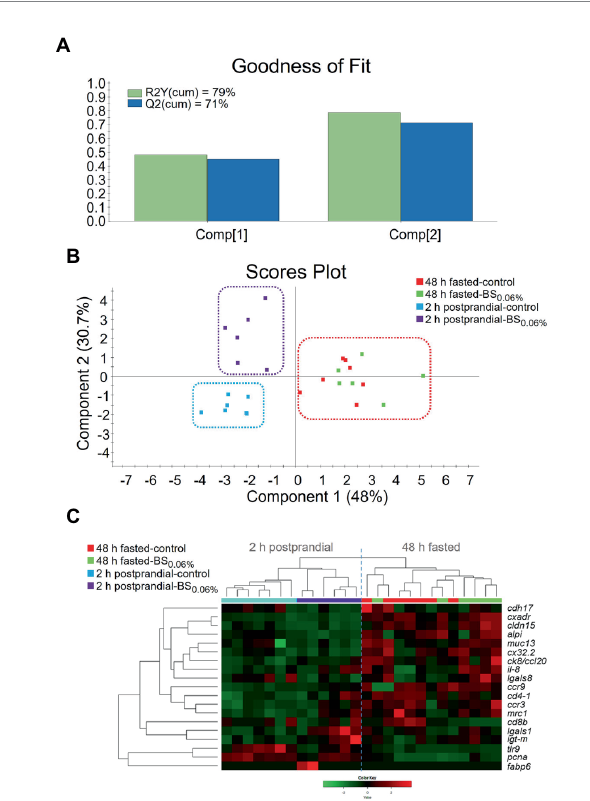
FIGURE 4 (A) Graphical representation of the goodness of fit of the PLS-DA model. (B) Scores plot for two-dimensional PLS-DA representing sample distribution between the two components of the model on the basis of their intestinal expression profiles based on statistically significant genes ( p < 0.1). (C) Heatmap plotting hierarchical clustering among statistically significant genes ( p < 0.1) on the basis of their expression pattern (Color Key scale) allowing to discriminate for sample distribution. Samples were obtained from anterior intestine (AI) of 48 h fasted- and 2 h postprandial-gilthead seabream ( Sparus aurata ; n = 8 per dietary treatment) that were fed the control and the experimental diet supplemented with a blend of bile salts at a dietary inclusion level of 0.06% (BS 0.06%